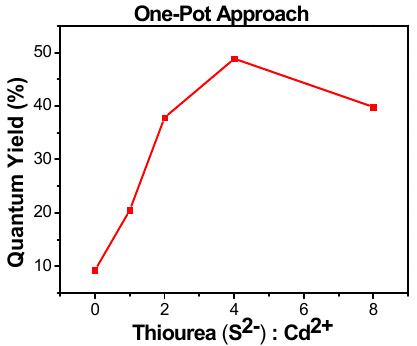
Figure 8. Fluorescence quantum yield (QY) versus ratio thiourea/Cd 2+ via the one-pot approach.